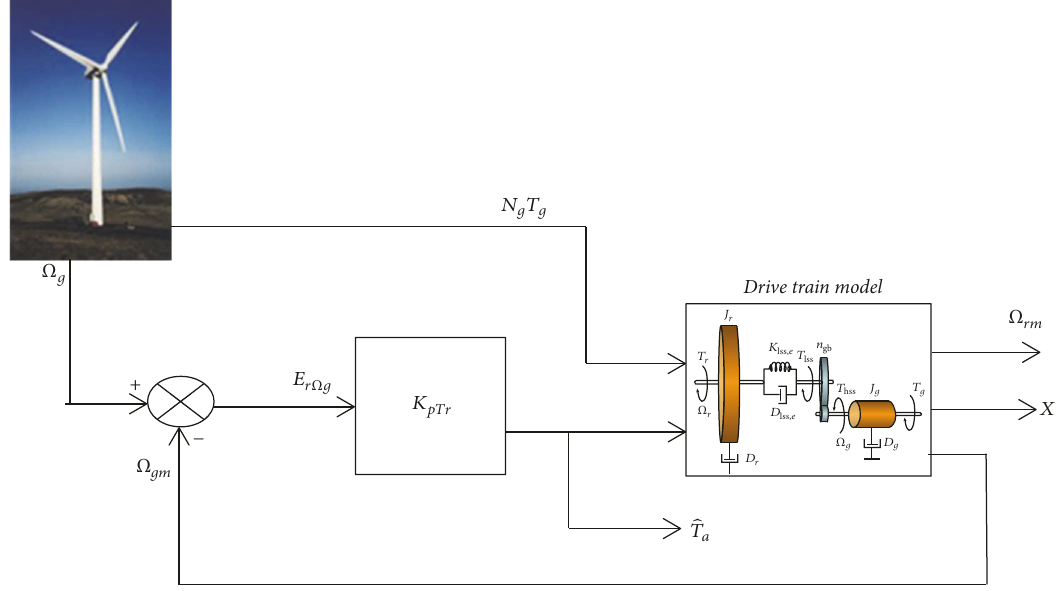
Figure 2: Aerodynamic torque feedback estimation